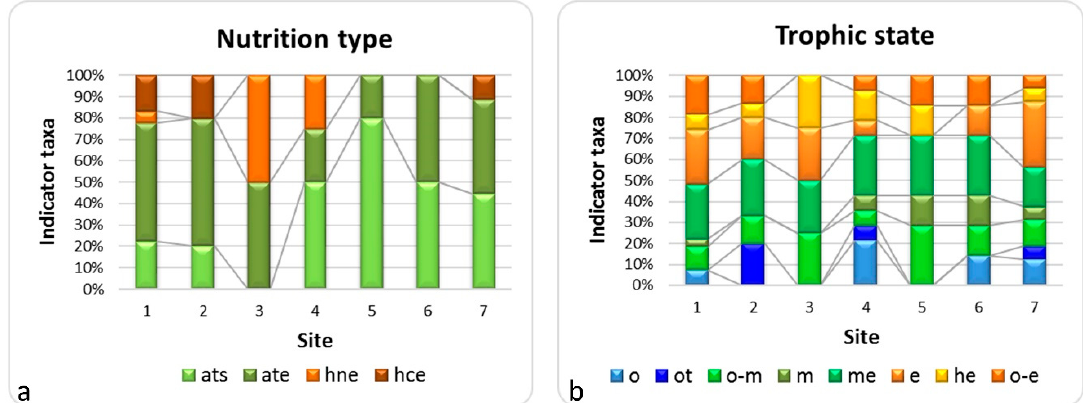
Figure 11. Ecological preferences of algal nutrition type indicators ( a ) and water trophic states ( b ) in the communities of studied sites in the Abraham Lincoln Birthplace National Historical Park. Names of sites are abbreviated as in Tables 1 and 2. Abbreviations of ecological groups of nutrition type: ats, strongly autotropes; ate, autotrophic withstand low nitrogen load; hne, particular heterotrophes (mixotrophes); hce, mixotrophes permanently in need of nitrogen load. Indicators of trophic states: o, ot, oligotraphentes; o-m, oligo-mesotraphhentes; m, mesotraphentes; me, meso-eutraphentes; e, eutraphentes; o-e, from oligo- to eutraphentes; he, hypereutraphentes. Autotrophes are green in the histogram and heterotropes are orangish-brown. In the histogram trophic state: oligotraphentes are blue, mesotraphentes are green, and eutraphentes are yellow-orangish.